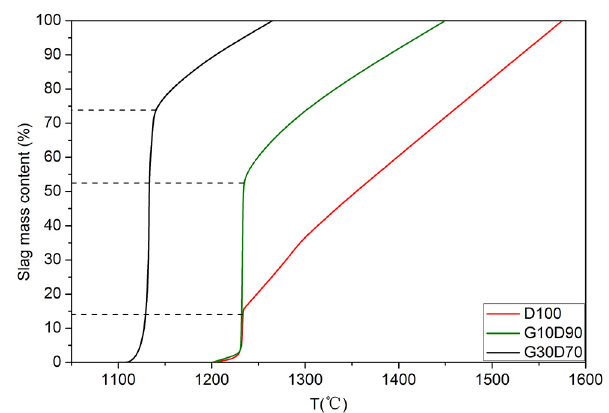
Figure 7. Comparison of the slag mass contents at each thermodynamic equilibrium state of the three blended ashes.